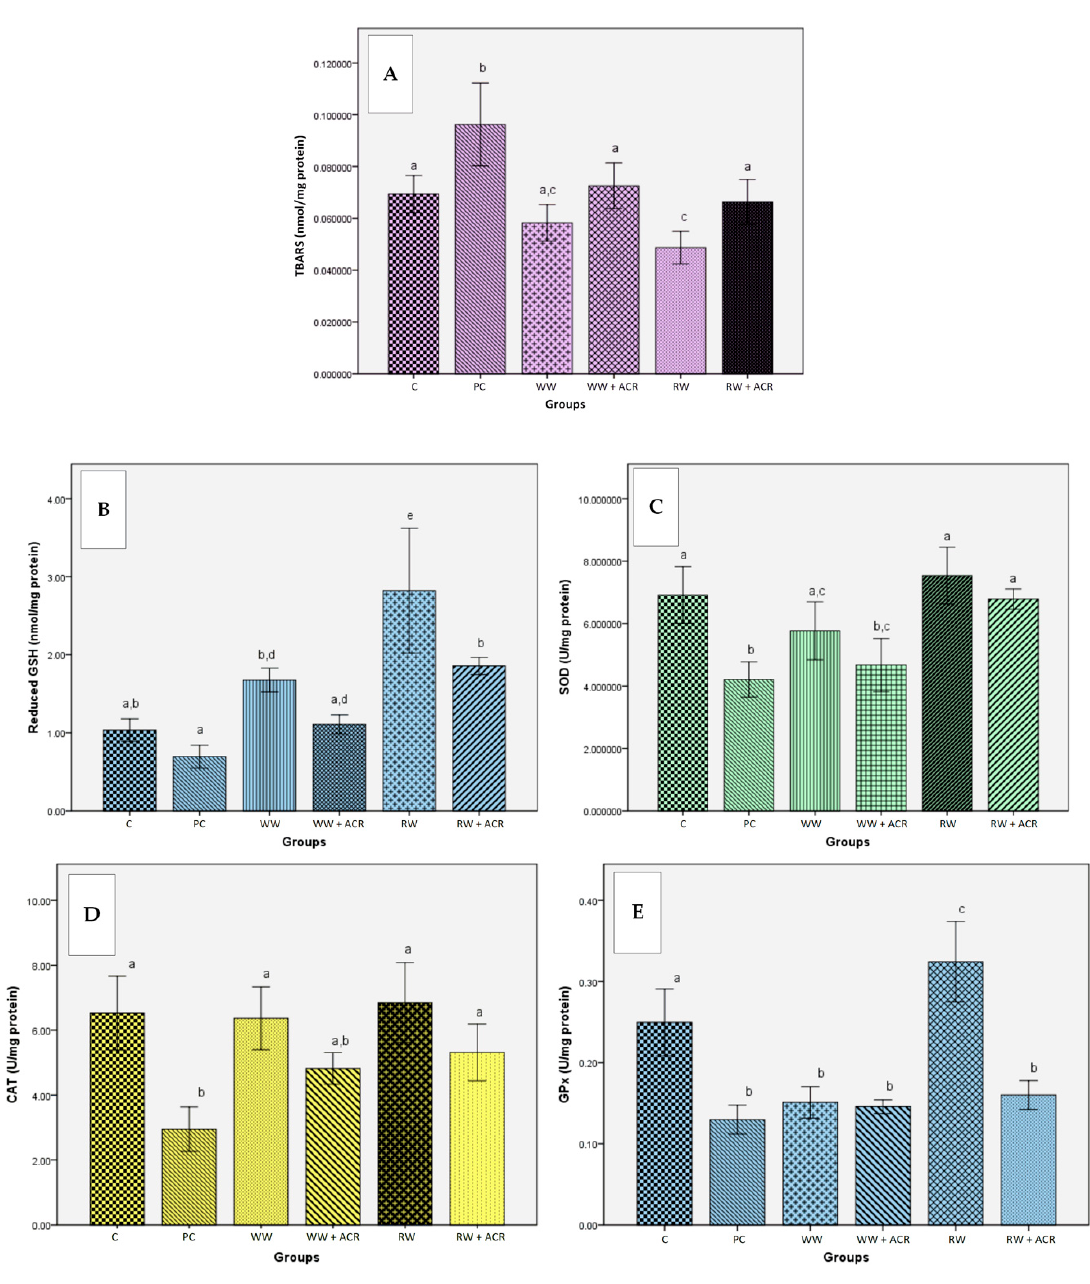
Figure 4. Effects of white/red wine on hepatic TBARS level (nmol/mg protein) ( A ) and reduced GSH hepatic level (nmol/mg protein) ( B ) in rats from ACR-treated groups compared to untreated ones ( n = 10). Effects of white/red wine on superoxide dismutase activity (U/mg protein) ( C ), catalase activity (U/mg protein) ( D ), and glutathione peroxidase activity (U/mg protein) ( E ) in liver tissue of rats from ACR-treated groups compared to untreated ones ( n = 10). Bars marked with the same letter do not differ significantly ( p < 0.05). C − hydroalcoholic solution group; PC − hydroalcoholic solution + acrylamide group; WW − white wine group; WW + ACR − white wine + acrylamide group; RW − red wine group; RW + ACR − red wine + acrylamide group.